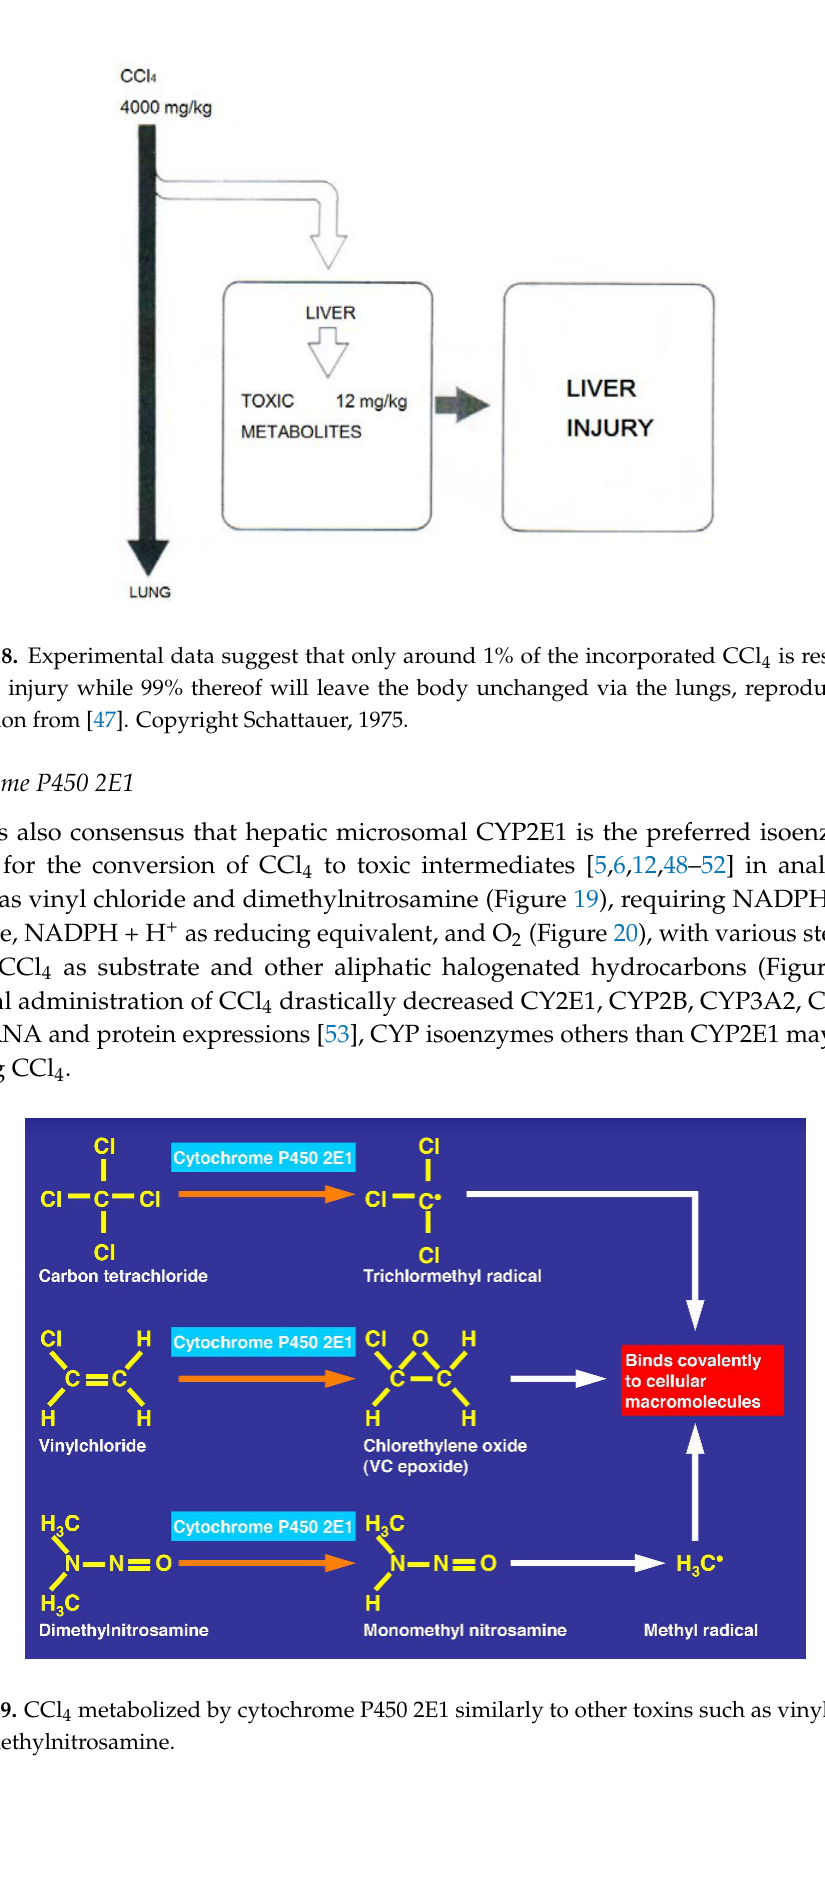
Figure 20. Involvement of cytochrome P450 in the microsomal metabolism of various substrates including aliphatic halogenated hydrocarbons with carbon tetrachloride as example. The NADPH-cytochrome P450 uses NADPH + H + and will itself be reduced, allowing the cytochrome P450 to be transferred from the oxidized state to the reduced state. The overall reactions needs also molecular oxygen and phospholipids.